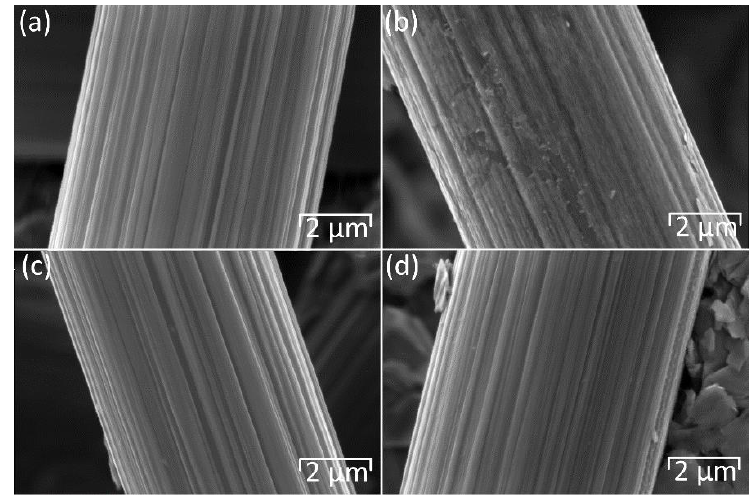
Figure 3. SEM images of materials before ( a , c ) and after ( b , d ) thermal oxidation at 550 °C for 5 h: ( a , b ) 28AA, ( c , d ) 36AA. Magnification 20 k. Accelerating voltage 5 kV. Working distance 14 mm.